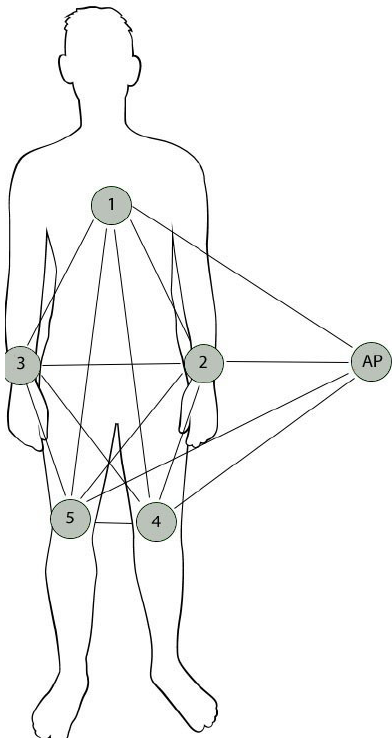
Figure 3. Experimental setup for network architecture with access point off the body. Note that the drawing assumes a single antenna at the AP, but up to four antennas are